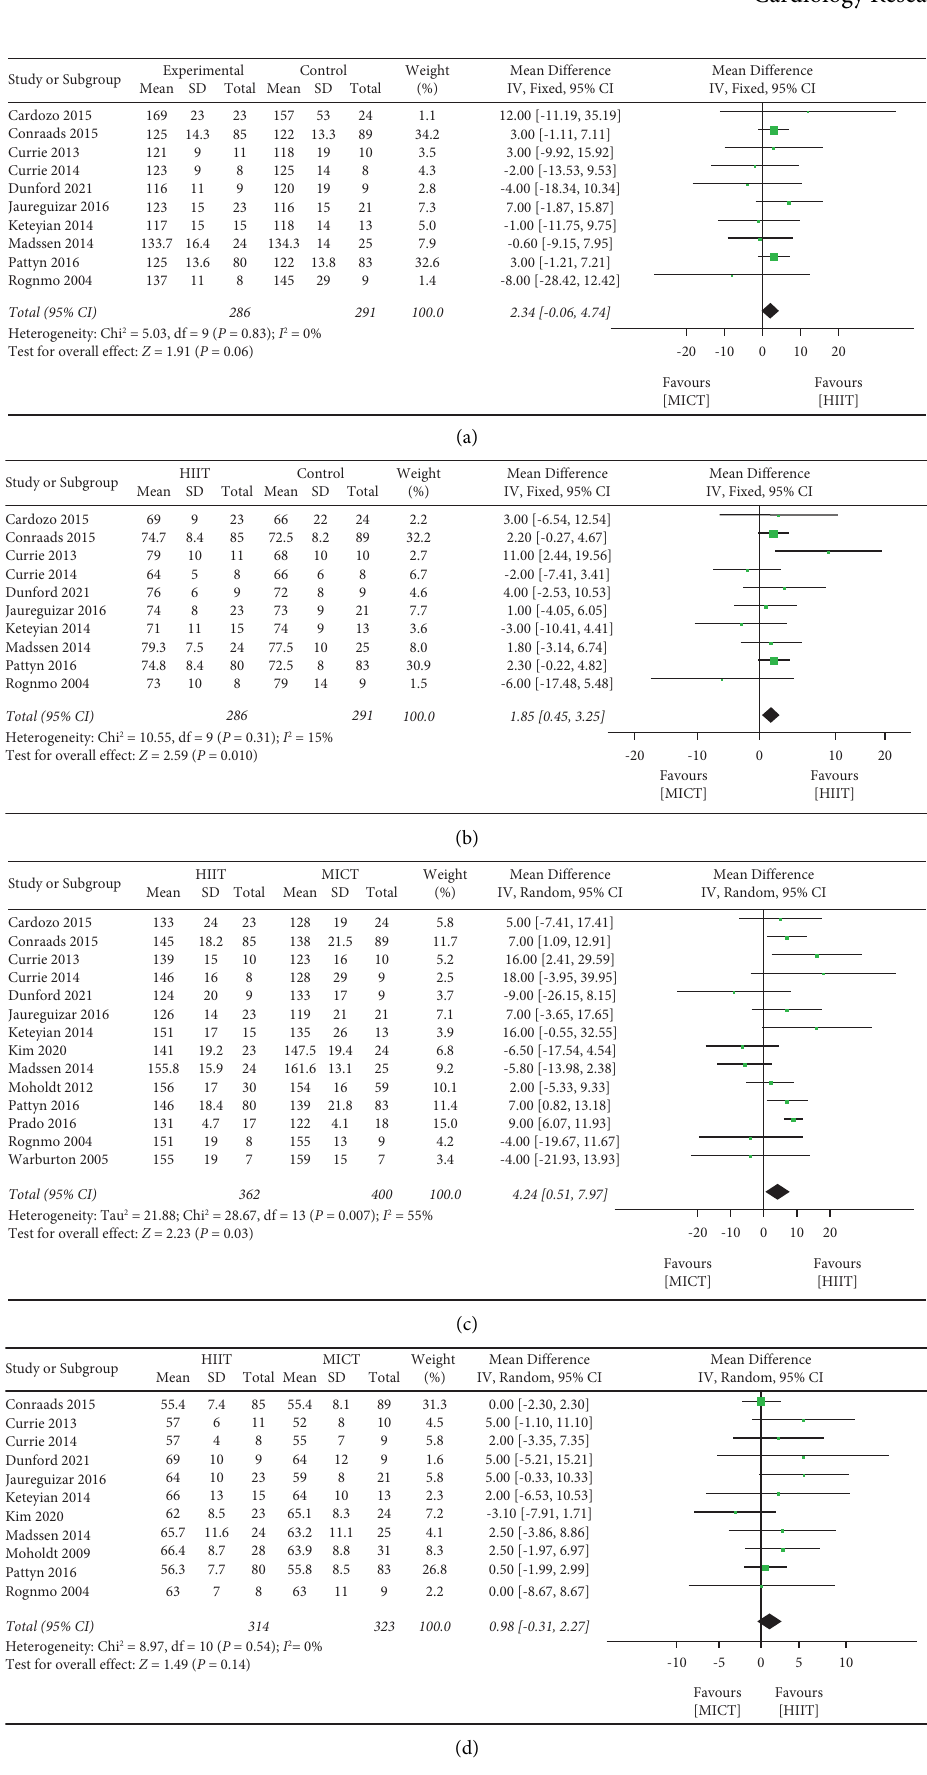
Figure 4: Meta-analysis results for (a) SBP (mmHg), (b) DBP (mmHg), (c) HR peak (mmHg), and (d) HR rest